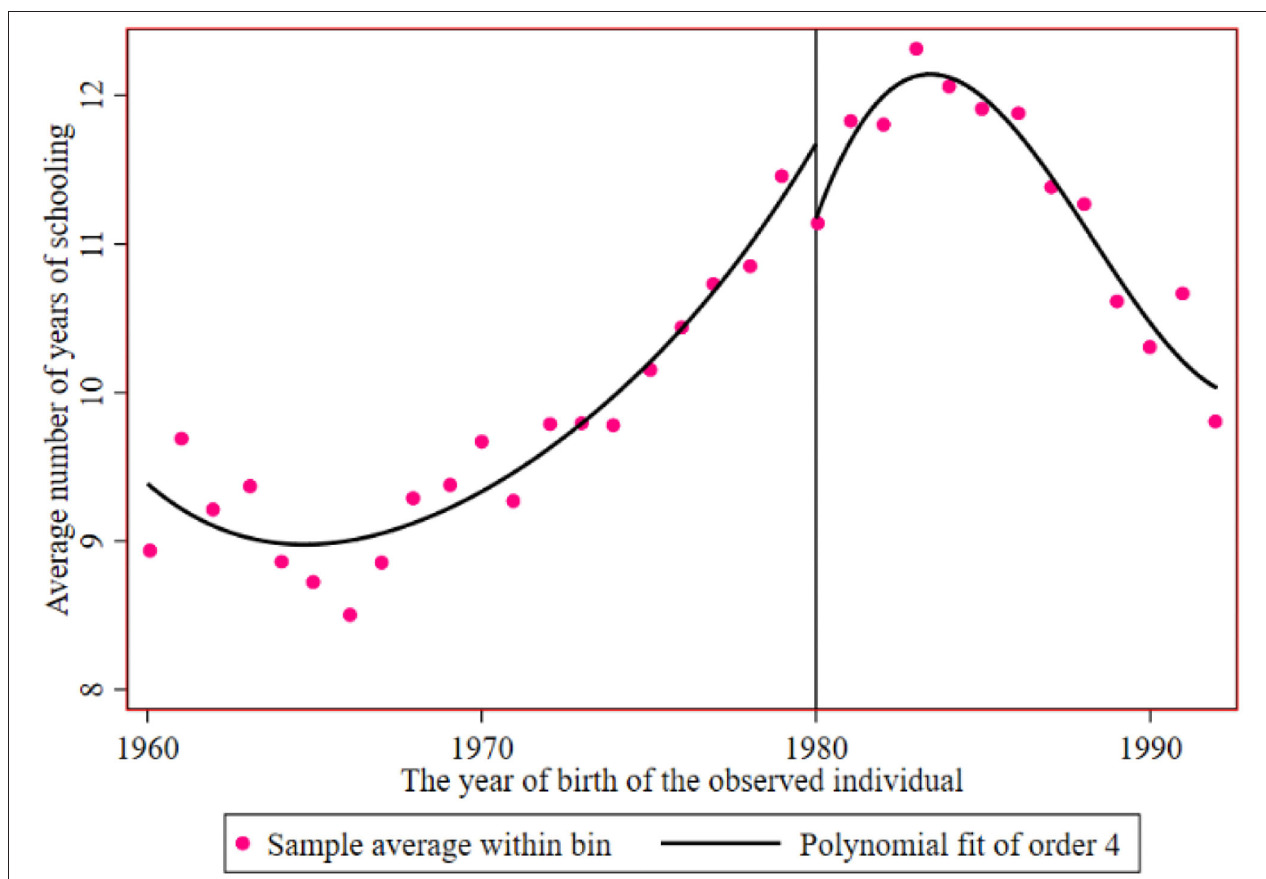
FIGURE 3 | The educational breakpoint of rural residents before and after the implementation of the reproductive health